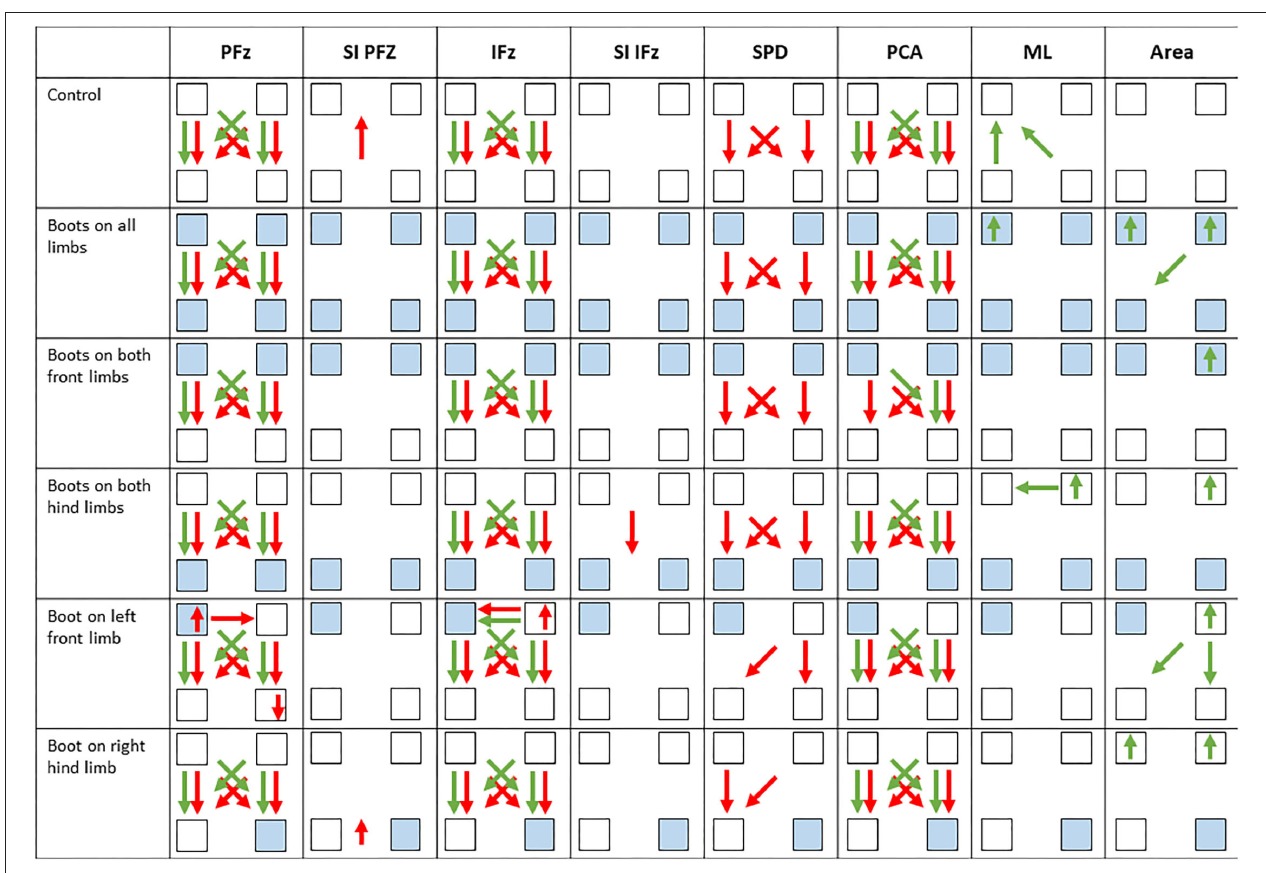
FIGURE 3 | Visualized overview of altered parameters, based on at least five steps/dog per measurement. Data were evaluated using a linear mixed model and post-hoc testing with Sidak’s alpha error correction. Each square represents a limb where those in blue represent boot-wearing limbs. The arrows between the squares show significant differences between the legs where the green represents walking and red for trotting. The arrowhead points in the direction of the lower value in each case. In case of a significant difference between the control and a test condition, an arrow within or beside the square indicates an increase or decrease of the value. For instance, when a dog boot was worn on the left front limb, PFz (%) at walk showed higher values in both front limbs and a decrease in the left front limb and an increase in the right hind limb compared to the control. Further, a significant difference between both front limbs was observed. PFz, peak vertical force; SI